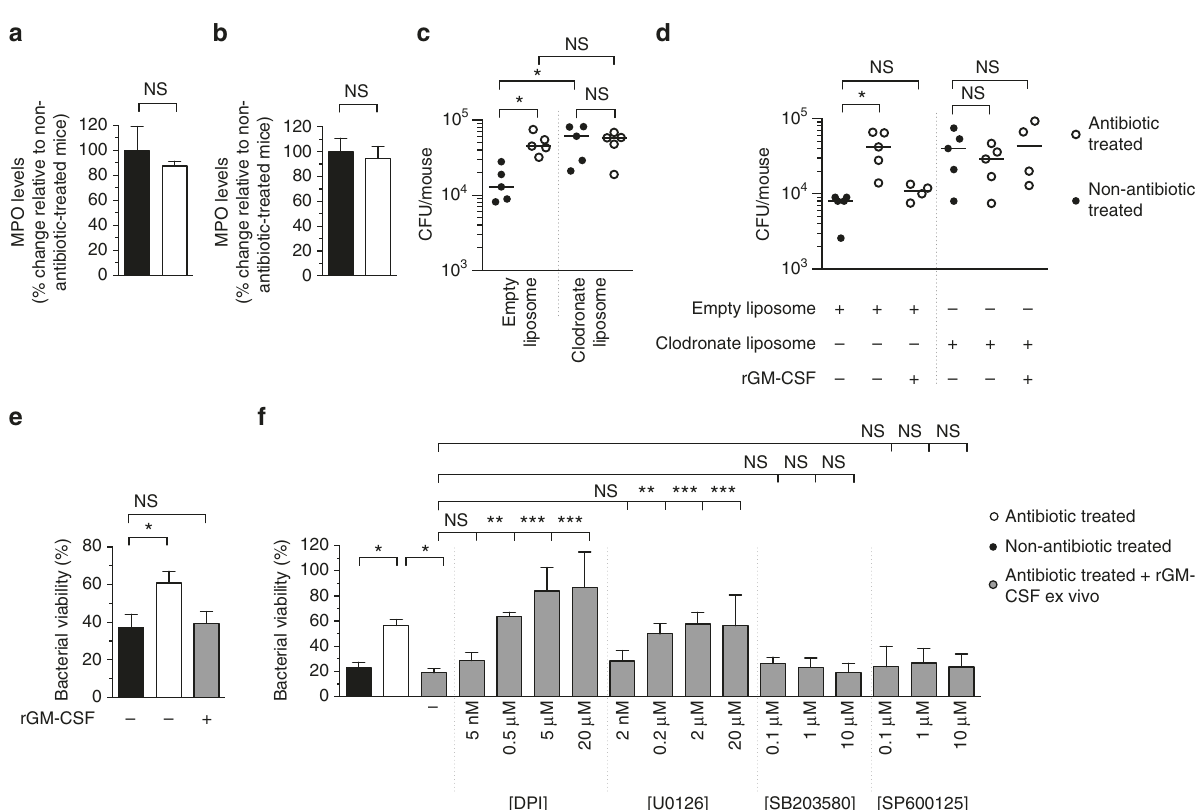
Fig. 3 The microbiota promotes alveolar macrophage-mediated clearance of bacteria from the lung and the antibacterial activity of these cells is promoted by GM-CSF signaling via the ERK pathway. a , b Myeloperoxidase (MPO) levels in the lung 12 h post-inoculation with S . pneumoniae ( a ) and K . pneumoniae ( b ). Statistical comparisons were by Mann – Whitney, data are from n = 5 mice/group and error bars are s.d. ( a , b ). c S . pneumoniae and d K . pneumoniae burden in the lung 12 h post-intranasal inoculation. Indicated groups were administered liposome clodronate, or empty liposomes, 48 h prior to lung infection. rGM-CSF (5 μ g/mouse) was given concomitant with intranasal inoculation with bacteria. Each data point represents a single mouse and horizontal lines indicate median value. e , f Alveolar macrophage killing of S . pneumoniae ( e ) or K . pneumoniae ( f ). Indicated groups of alveolar macrophages were treated with rGM-CSF (100 ng/mL) for 1 h and then either U0126 for 1 h, SB203580 for 1 h, SP600125 for 1 h, DPI for 30 min, or inhibitor vehicle control (DMSO, denoted by “ − ” ) for 1 h prior to incubation with bacteria. Inhibitor concentration is displayed below each bar. Values are from n = 4 mice/ group and error bars are s.e.m. Statistical comparisons were by one-way ANOVA with post-hoc Sidak ’ s or Dunnett ’ s test as appropriate ( c , e and f ) and Kruskal – Wallis test with Dunn ’ s multiple comparison test ( d ), * P < 0.05, ** P < 0.01, *** P < 0.001, and NS, not signi fi